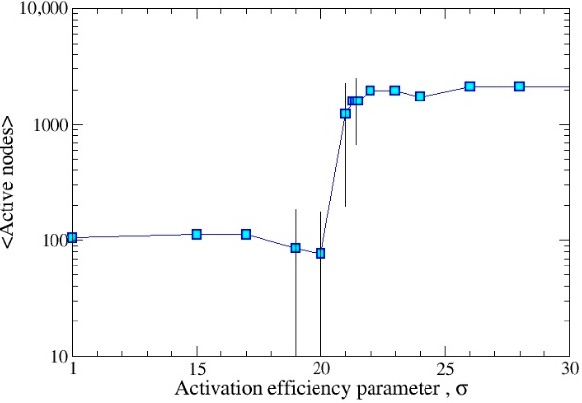
Figure 1. Transition from migration to colony formation regime. The transition is represented by the mean value of the active nodes vs. the activity efficiency rate, σ . Each node corresponds to the mean calculated over 11 realizations, using f 0 = 0.05 on a 200 × 10 network. The line is a guide for the eye. The error bars are reported when significant. The transition from migration (few active nodes) to colony formation (200 × 10 active nodes) is quite sharp in the range of σ =